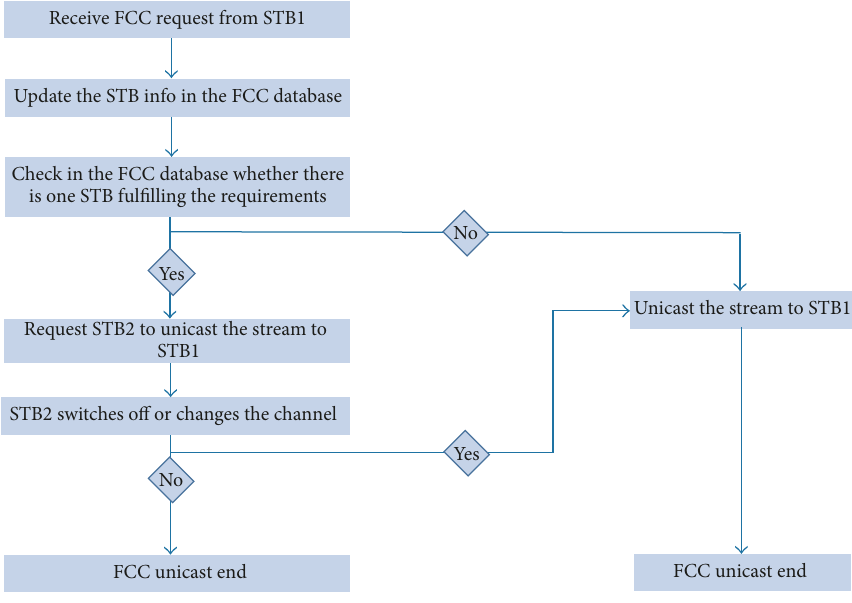
Figure 9: The proposed FCC solution main steps.